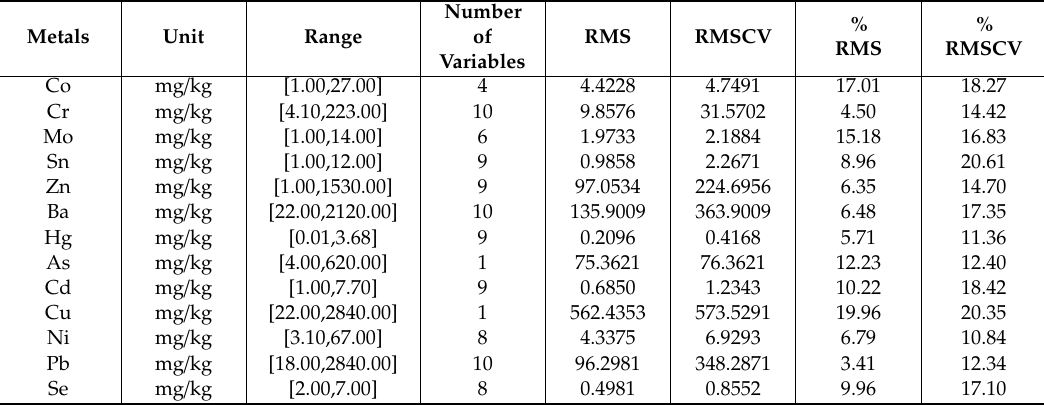
Table 3. The RMS and RMSCV values for the PLS model based on ATR data in the